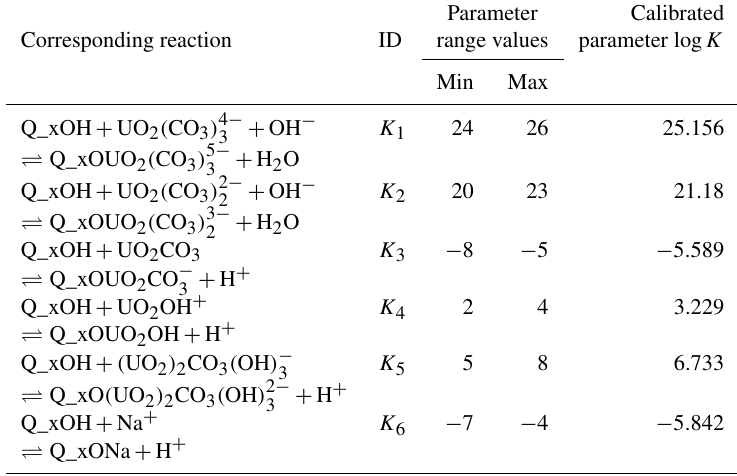
Table 1. Complexation reactions with their respective log K range